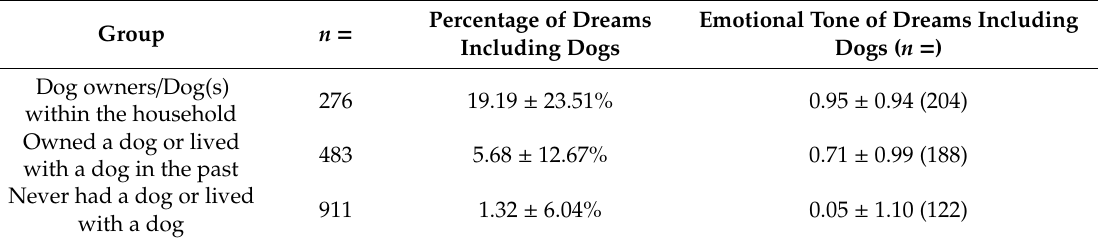
Table 3. Means and standard deviations for percentage of dreams that include dogs and the emotional tone of dreams that include